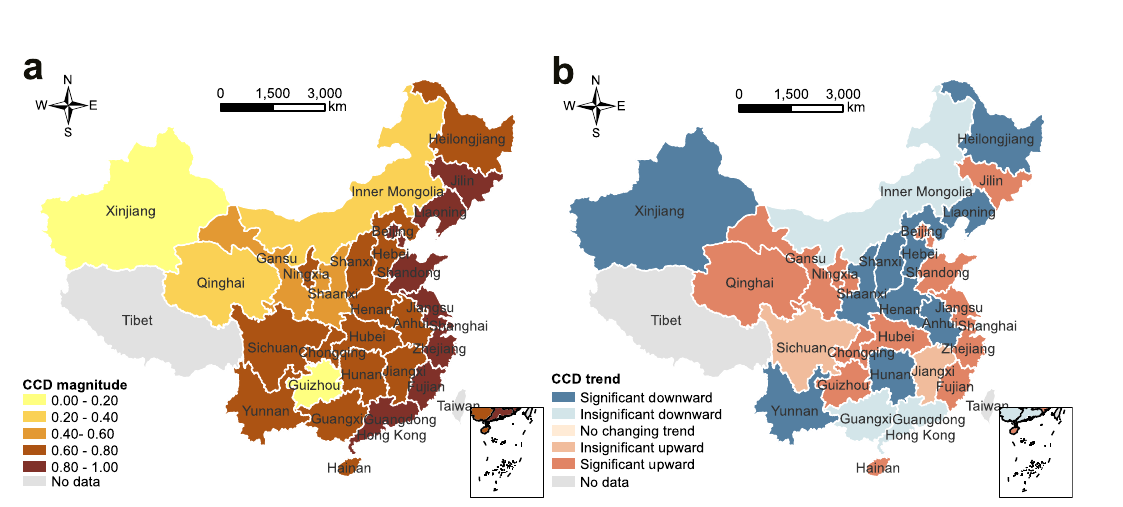
Fig. 6 | Spatial patterns of coupling coordination degree between environmental performance and human well-being from 2000 to 2018. a The magnitude. b Changing trends. The coupling coordination degree scopes are listed in Table S5, referring to Shi et al. 36 and Li et al. 78 . The given signi fi cance level α is